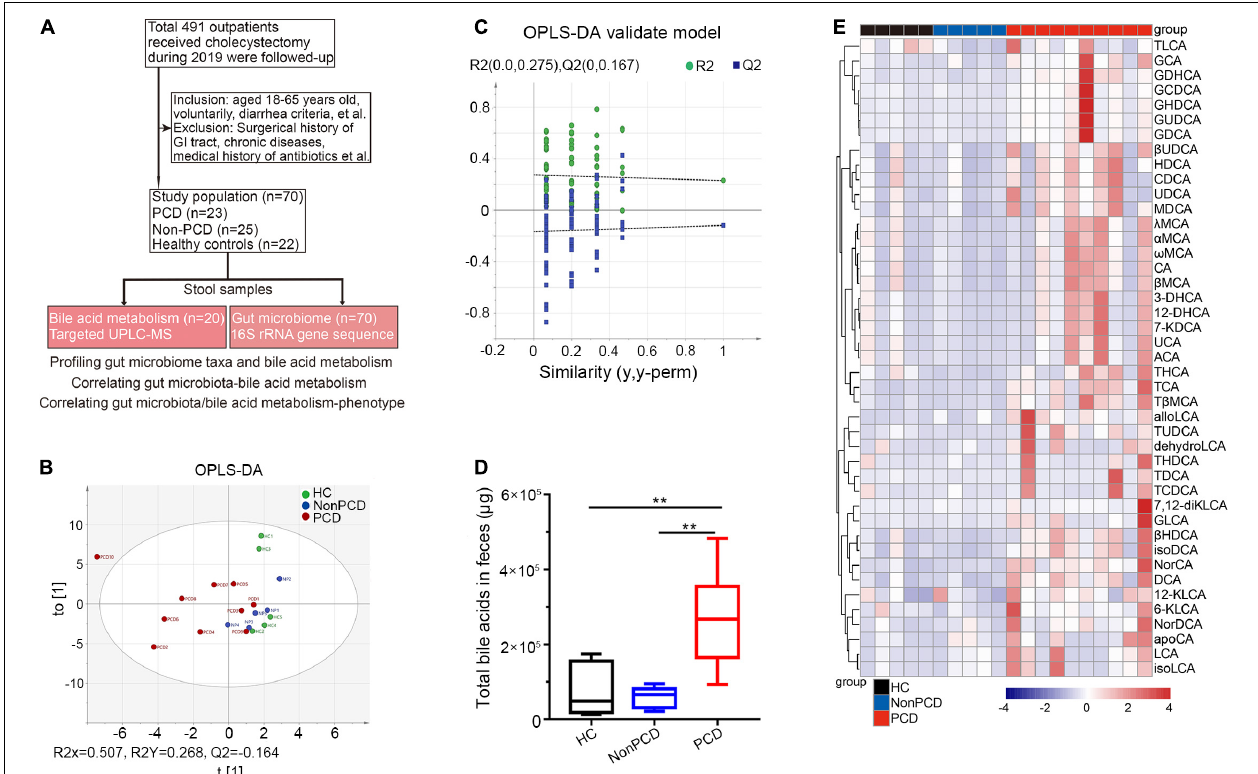
FIGURE 1 | Metabolic changes of fecal bile acids in PCD patients compared to Non-PCD and HC. (A) Flow chart of this study. (B) Orthogonal Projections to Latent Structures Discriminant Analysis (OPLS-DA) plot revealing metabolic deviation of fecal bile acids composition from PCD ( n = 10) to Non-PCD ( n = 5) patients and HC ( n = 5) (R2Y = 0.268, Q 2 = -0.164). (C) Representative permutations plot was applied as OPLS-DA validate model among three groups in bile acid metabolism. (D) Box plot presenting excessive total bile acids output in feces from PCD, compared to Non-PCD and HC. Data are shown as Min to Max; n = 5 for Non-PCD and HC, 10 for PCD patients ** p < 0.01. (E) Representative heatmap showing quite distinct fecal content of these 43 bile acids detected among three groups; total fecal bile acid excretion of donor was calculated by the concentration (ng/g) × defecation output